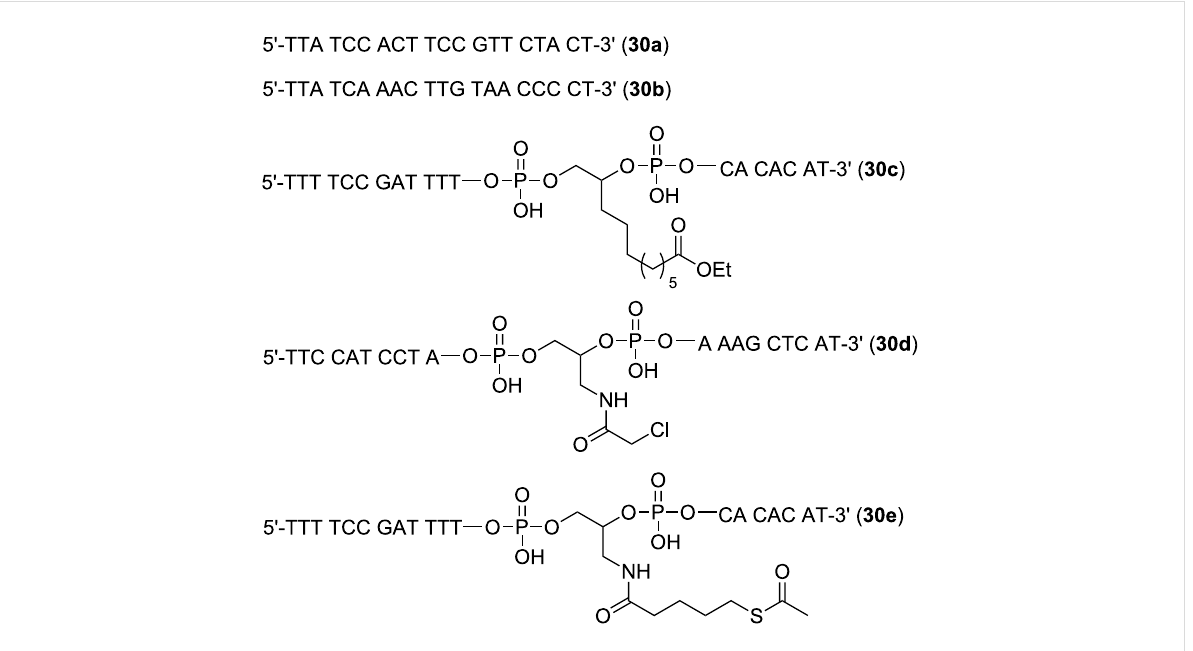
Figure 3: ODN sequences 30a–e . Their 5'-tritylated versions are labeled as 30a-tr , 30b-tr , 30c-tr , 30d-tr , and 30e-tr , respectively.